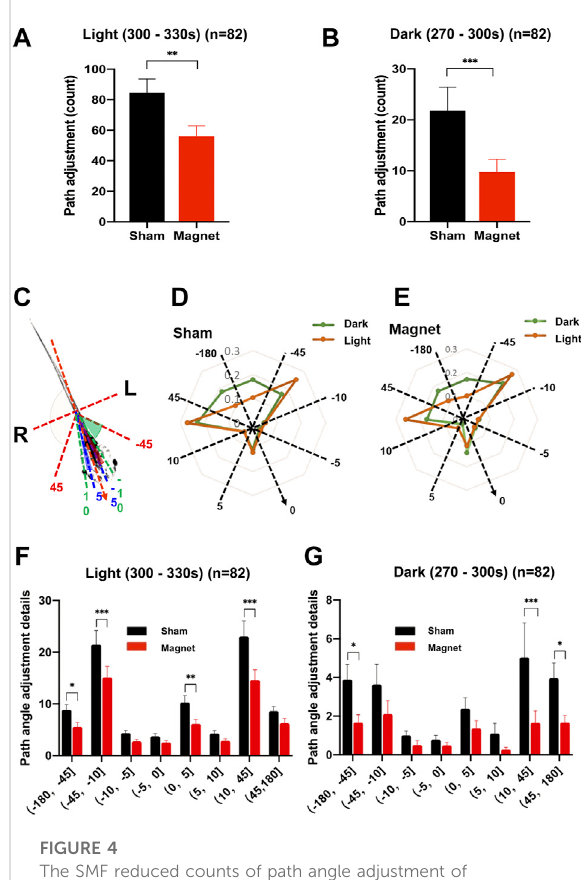
FIGURE 4 The SMF reduced counts of path angle adjustment of swimming tadpoles. (A,B) SMF-induced reduction in total counts of path angle adjustments in light (A) and dark (B) . (C) Schematic diagram illustrating the direction and angles adjusted during swimming. The centerline along the body axis from head to tail refers to the previous direction of locomotion. The directional adjustment to theright(R)ofthebody isdetermined aspositive (+) and to the left (L) as negative (-). (D,E) Path angle adjustment pattern ofthetadpolesshows nodifference betweenthesham (D) and the magnetic (E) treatment shown by the spider plot. The dashed lines divided the groups with angle setting of (0 ° – 5 ° ], (5 ° – 10 ° ], (10 ° – 45 ° ], (45 ° – 180 ° ]. The orange and green dot lines show the ratio of adjustment counts in each quadrant compared to the total counts during the light pulse and dark interval, respectively. (F) The SMF inhibits the counts of left sided large- angle (45 – 180 ° ), both right and left sided medium-angle (10 – 45 ° ), and right sided direct-angle (0 – 5 ° ) path adjustments in the light. (G) The SMF inhibits the counts of both right and left sided large- angle (45 – 180 ° ) and right-sided medium-angle (10 – 45 ° ) path angle adjustments in the dark. n is the total number of tadpoles fromseven experiments,twelve tadpolesper experiment. Dataare expressed as mean ± SEM. The p values were calculated using the Wilcoxon matched-pairs signed-rank test (A,B) and the two-way ANOVA (F,G) test. * p < 0.05, ** p < 0.01, *** p <